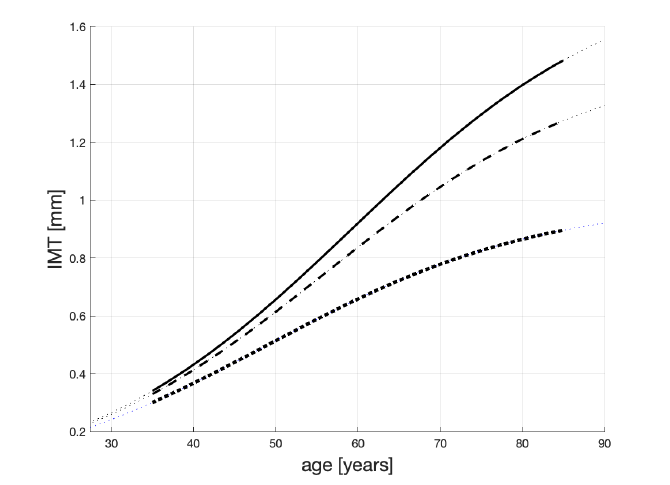
Figure 1. Possible IMT time profiles in persons with different atherosclerosis status. The dashed line represents atherosclerosis non-sufferers; the solid line—non-healthy but not necessarily “heavy” sufferers; the solid line—“heavy”